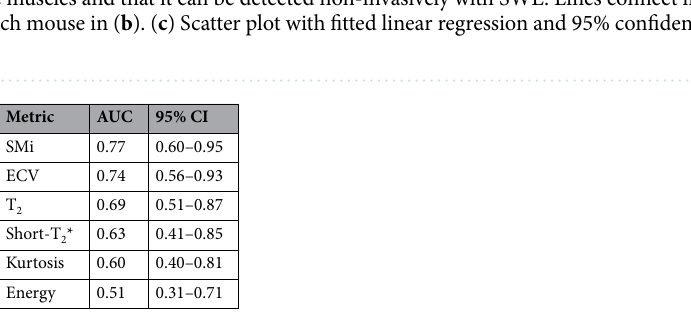
Table 1. ROC analysis for NMR and SWE metrics that correlated with collagen fraction. AUC area under the curve, CI confidence interval, SWE shear-wave elastography, ECV extracellular